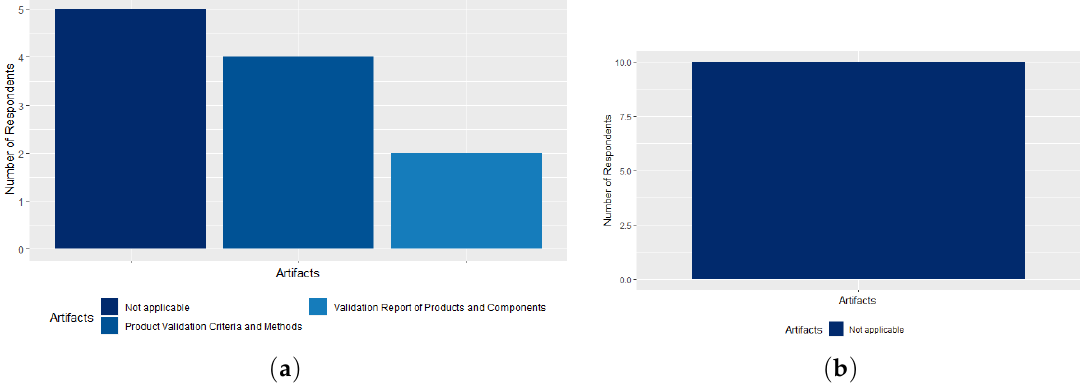
Figure 19. ( a ) The ICT Contract Management process artifacts; ( b ) the Change Management process